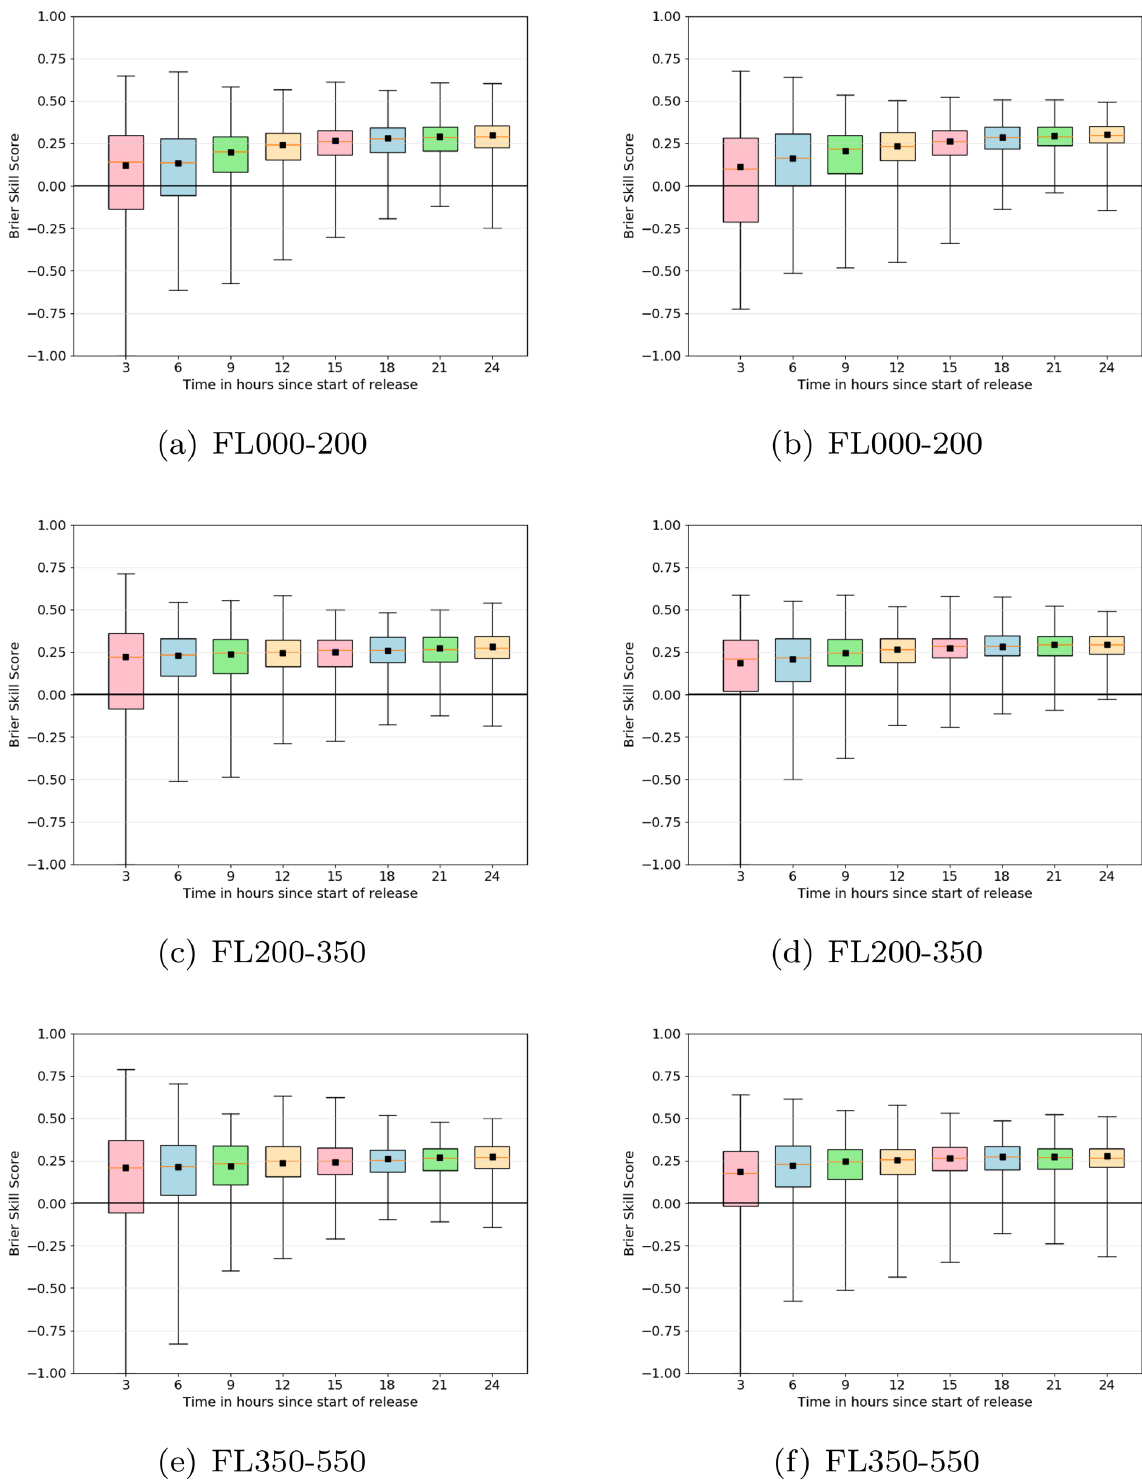
Figure 7. Adjusted Brier skill score against forecast time for ash concentration exceeding 5mgm − 3 on three flight levels: (a) Fl000-200, (b) FL200-350, and (c) FL350-550. The left-hand-side column is for a 12km eruption of Hekla and the right-hand-side column is for a 25km eruption of Öraefajökull. Black squares show average Brier skill scores and the box and whiskers show the range of adjusted skill scores for each individual